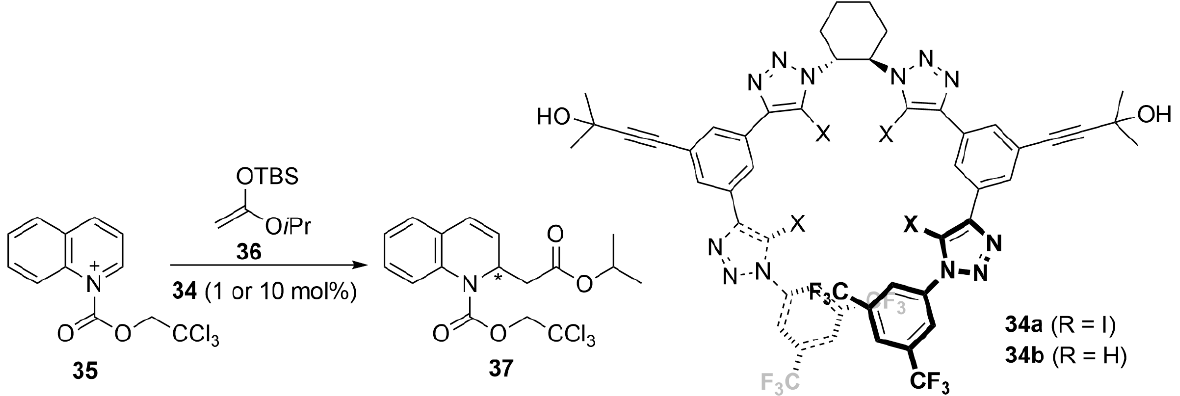
Figure 19. XB-catalyzed asymmetric Reisser-type reaction.